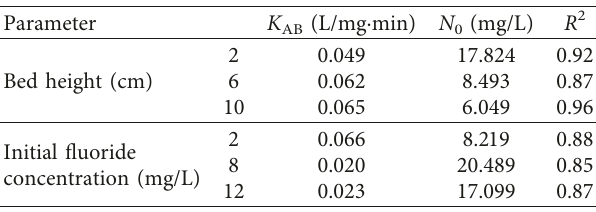
Figure 11: Adams–Bohart model at different (a) bed heights (pH � 3, treated volume � 100ml, flow rate � 4ml/min, and initial fluoride concentration � 2mg/L) and (b) initial fluoride concentrations (pH � 3, treated volume � 100ml, flow rate � 4ml/min, and bed height � 6cm). Table 8: Adams–Bohart constants at different conditions for the fluoride adsorption by QPKS using linear regression analysis.